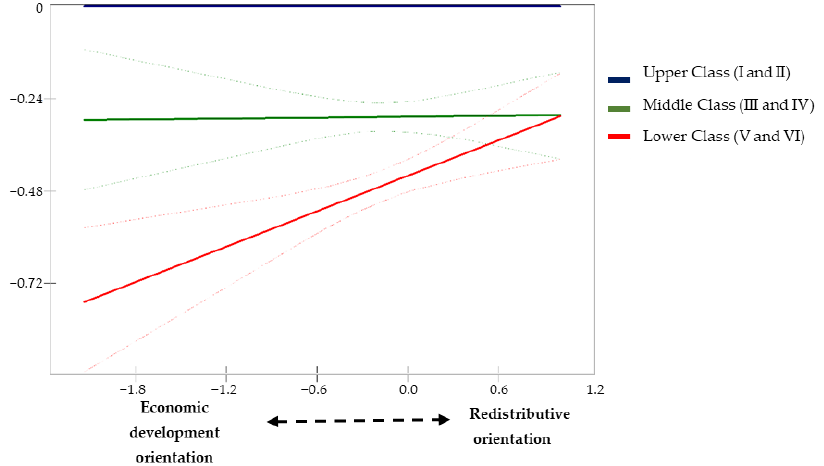
Figure 3. Differences in the adoption of healthy practices compared with Upper Class (I and II)